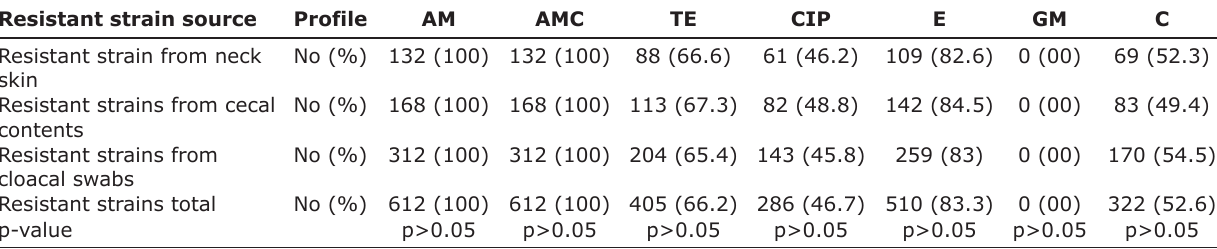
Table-3: Antimicrobial resistance rates of thermotolerant Campylobacter isolated strains. Resistant strain source